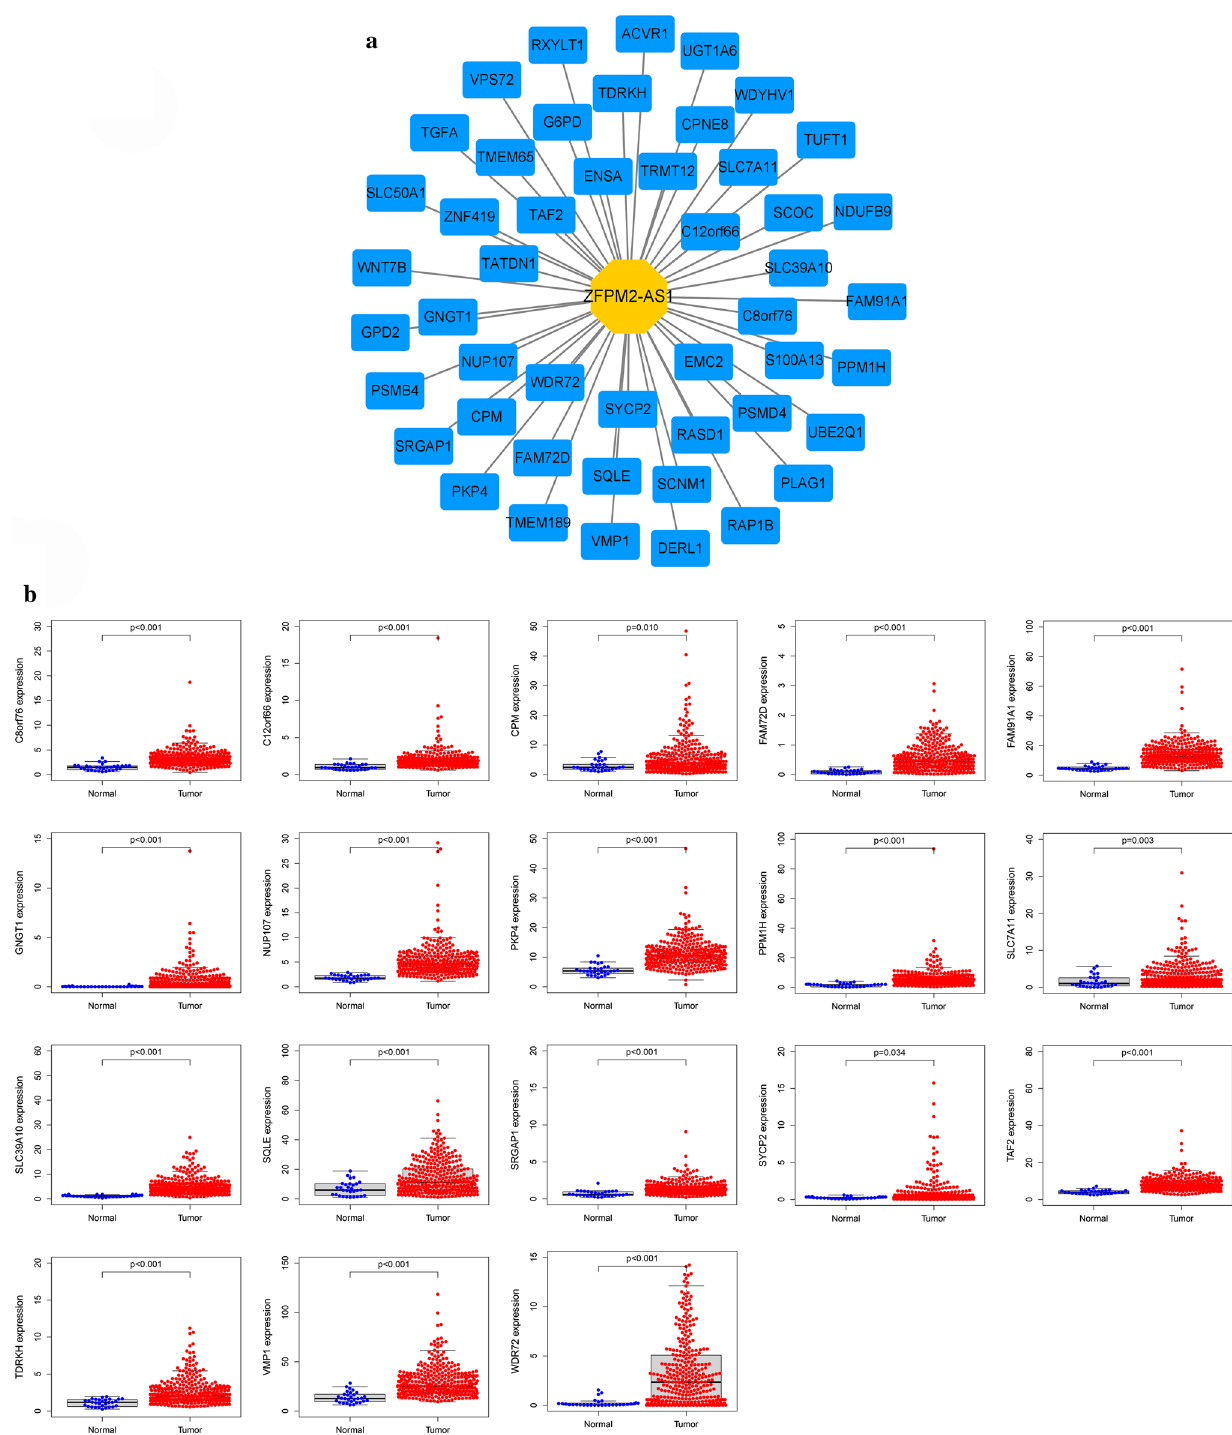
Fig. 9 The co-expression network of ZFPM2-AS1 in GAC. a Construction of the ZFPM2-AS1-mRNA co-expression network. b Differential expression of target mRNAs in GAC samples and normal samples from